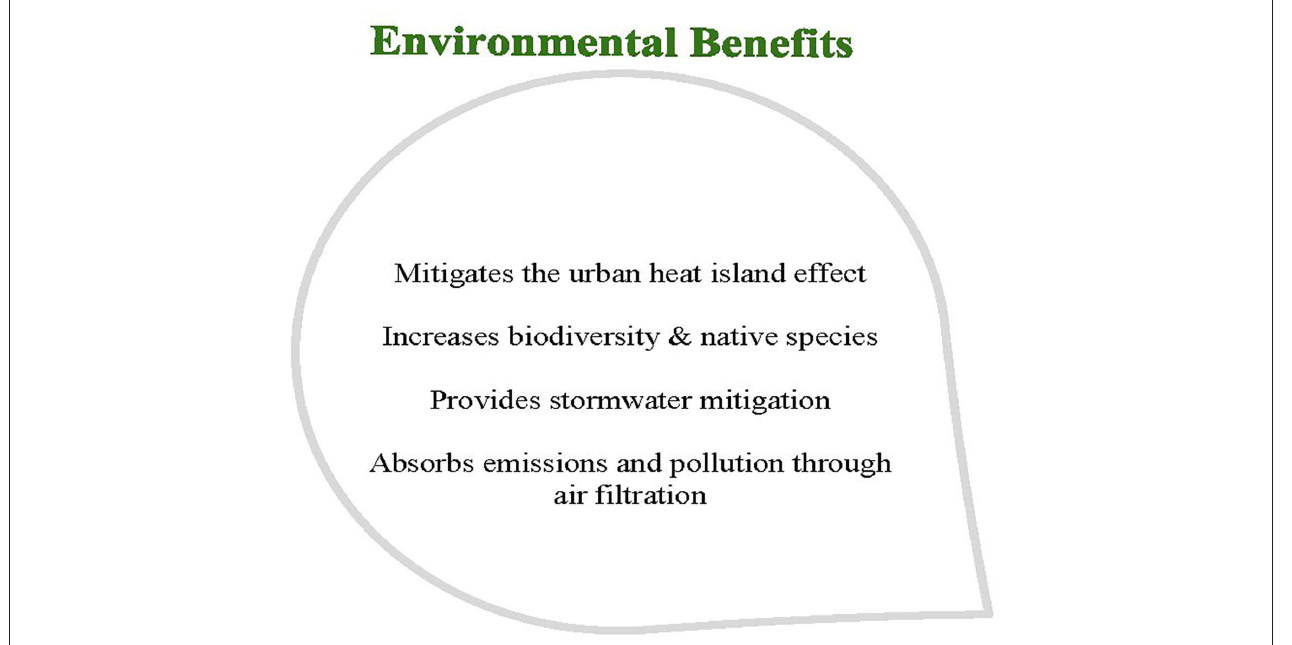
FIGURE 2 | Summary of environmental benefits for green roofs on